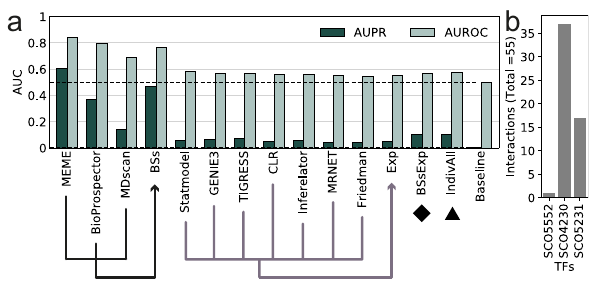
Figure 3. ( a ) AUROC and AUPR for each of the methods and the community networks. ( b ) Number of interactions statistically validated by